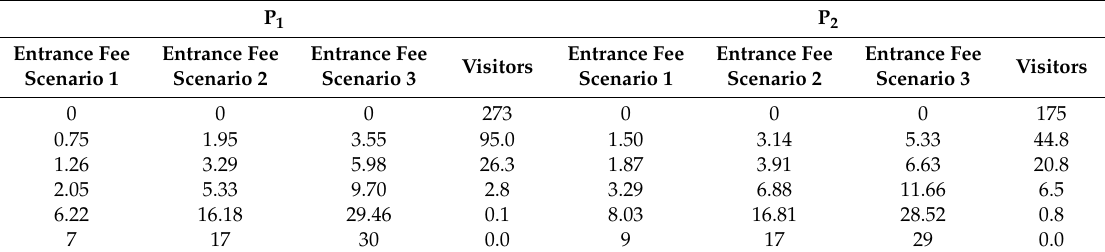
Table 10. Transformed demand function points for the SPNP (P 1 and P 2